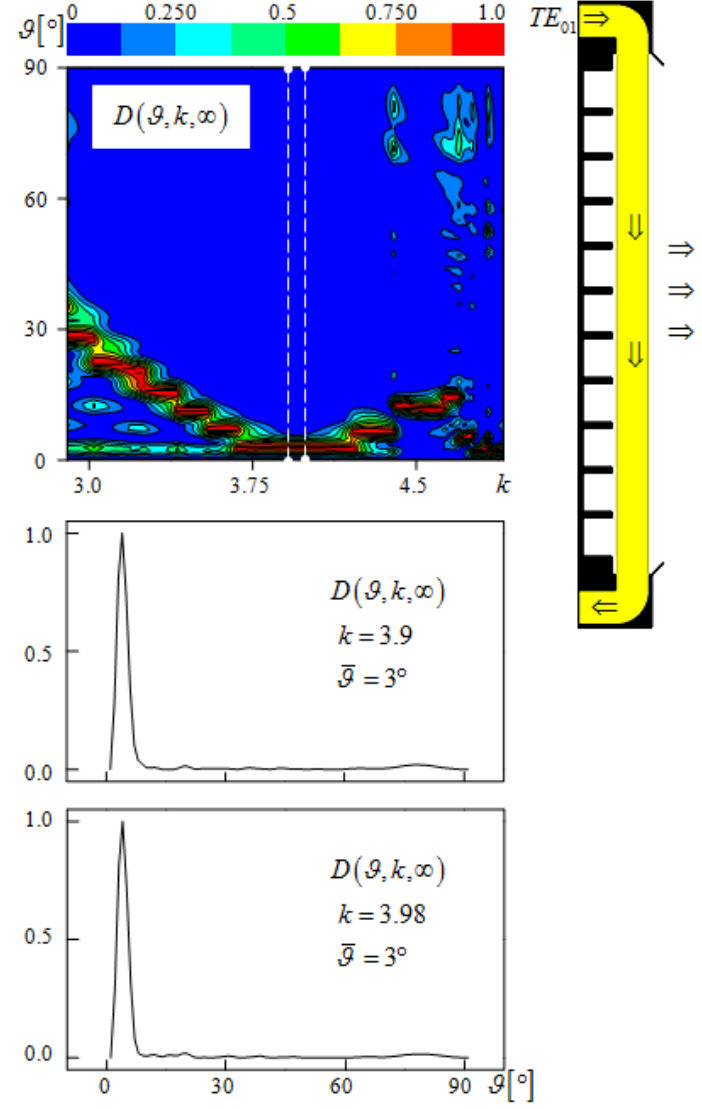
( ) , , D k ϑ ∞ in the frequency